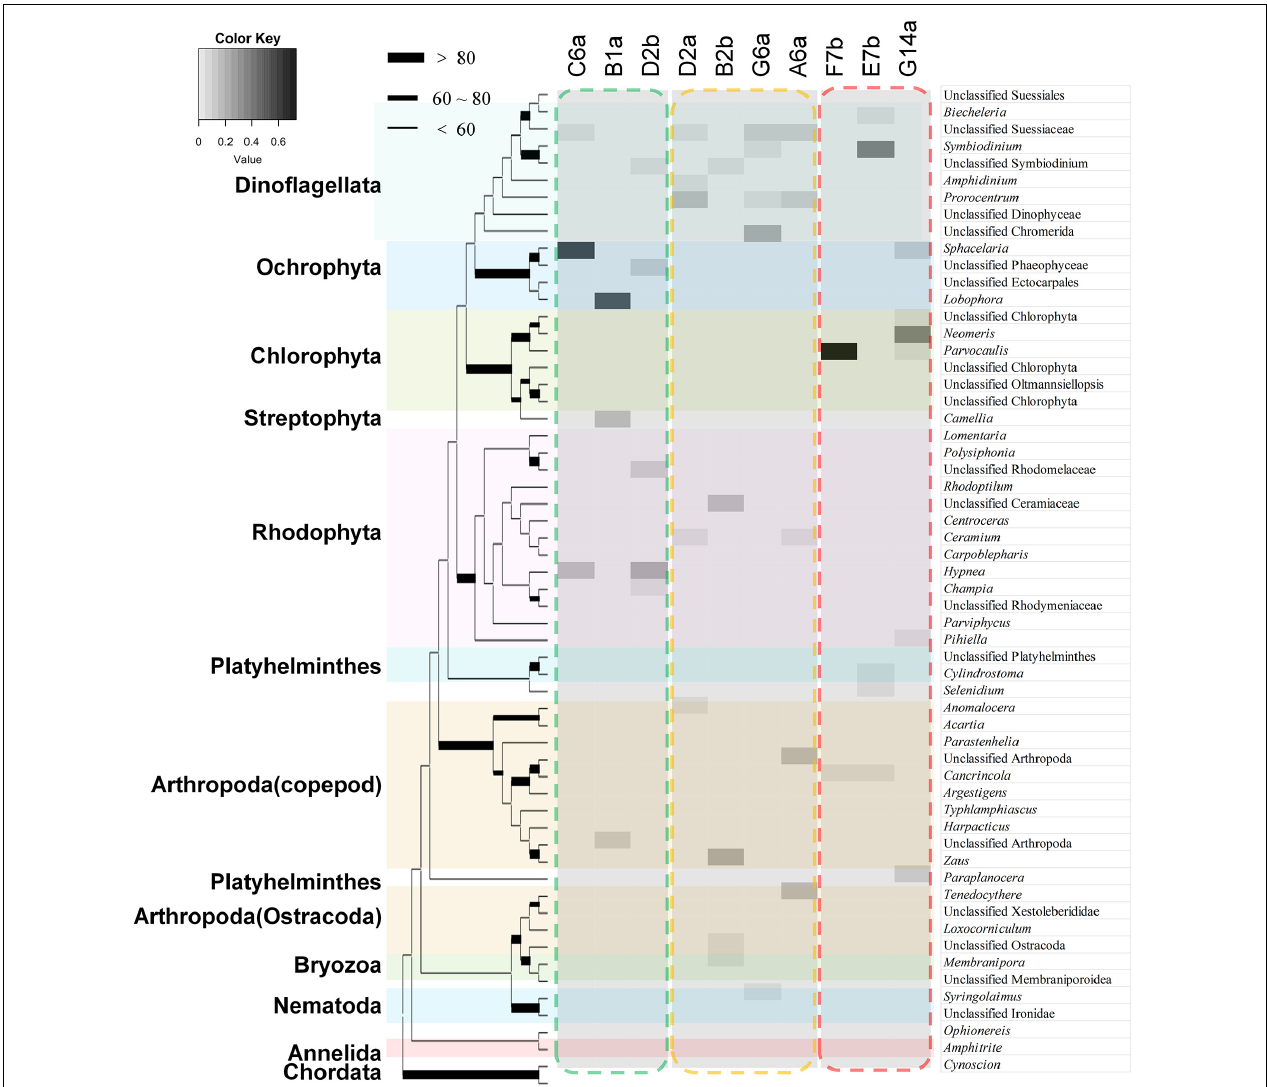
FIGURE 4 | The main species in the stomach contents of Ctenochaetus striatus (as revealed by DNA analysis) at the genus level showed distinct divergences among reefs. The characters above the picture represent the IDs of the sampled sites. The taxonomic species in the green dashed frame was the main species detected in the stomach contents of C. striatus sampled from high coral cover (HC) reefs, the orange dashed frame surrounds the main feeding items on intermediate coral cover (IC) reefs, and the red dashed frame represents the detected species on the samples of low coral cover reefs. Brown and red algal species were more frequently detected in the stomach contents within HC reefs. On IC reefs, the stomach content DNA tended to be more diverse and was mainly comprised of dinoflagellates. Green algae were the most abundant taxa on the reefs with high macroalgae or long algal turfs coverage, except site